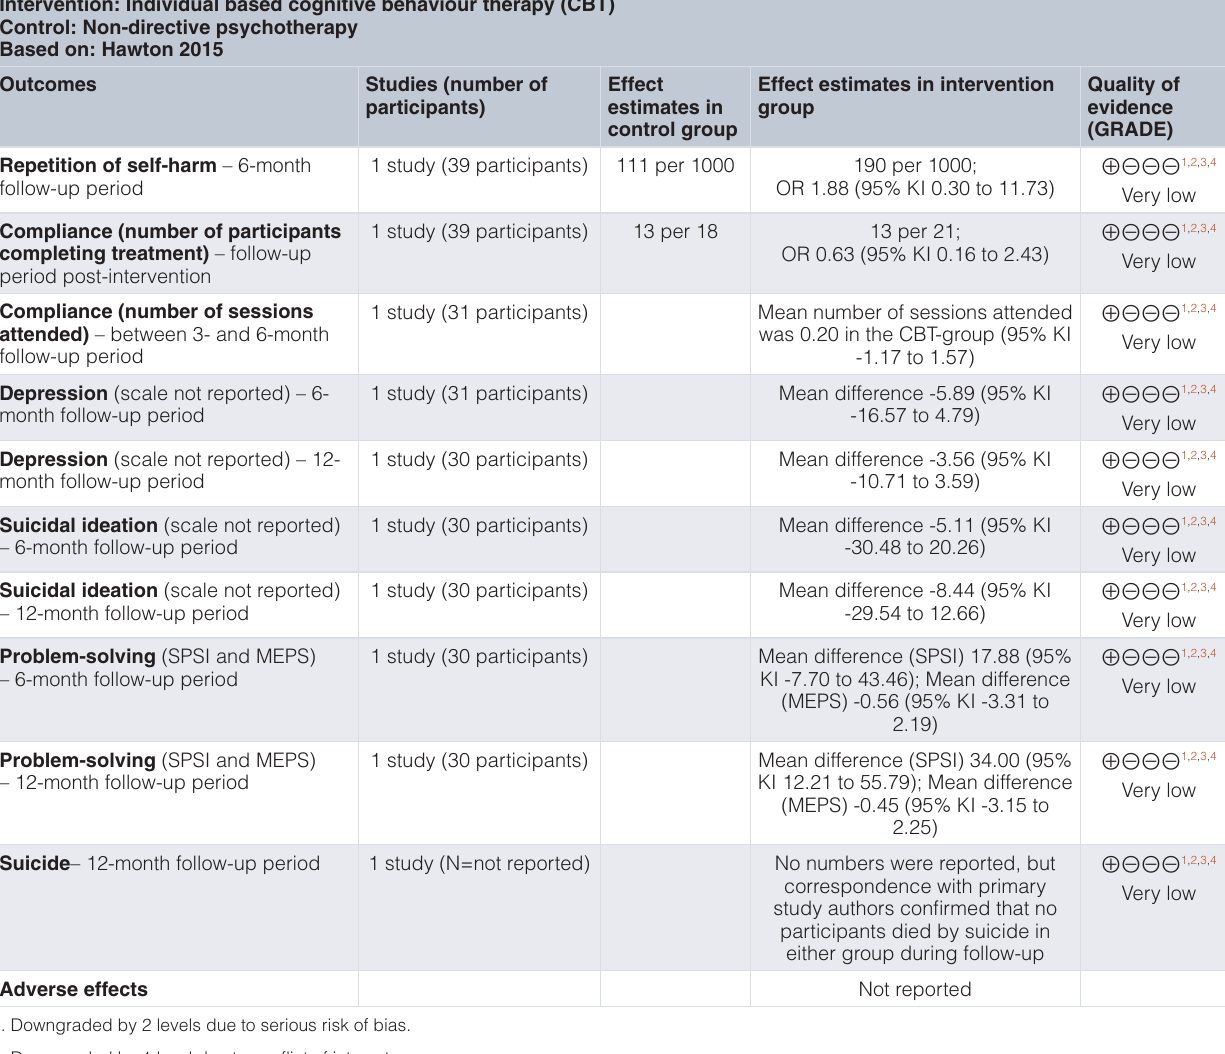
Table 10. GRADE-assessment: Interventions for existing self-harm: individual based cognitive behaviour therapy (CBT) versus non- directive psychotherapy. Population: Adolescents, 12 to 17-year olds, presenting to paediatric facilities following self-injury in which an intent to die was indicated Intervention: Individual based cognitive behaviour therapy (CBT) Control: Non-directive